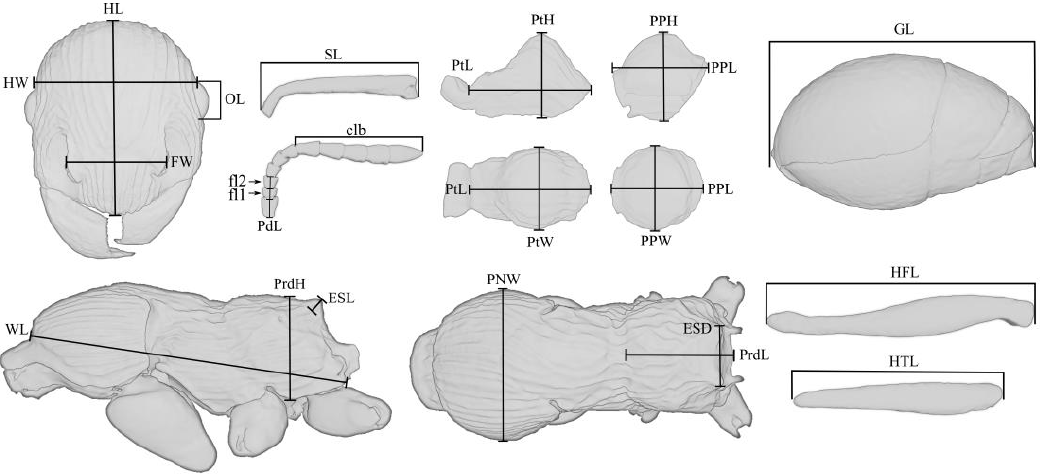
Figure 1. Main measurements of the † Manica andrannae sp. nov. (explanation in the text above).